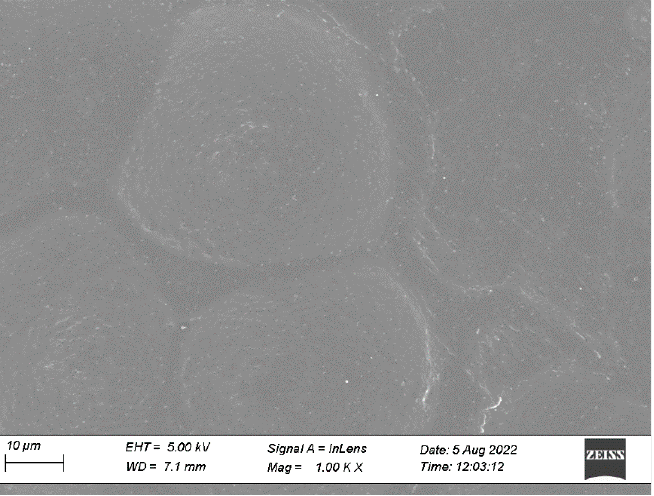
Figure 9. Scanning electron microscopy image of the optimized drug in the adhesive patch.